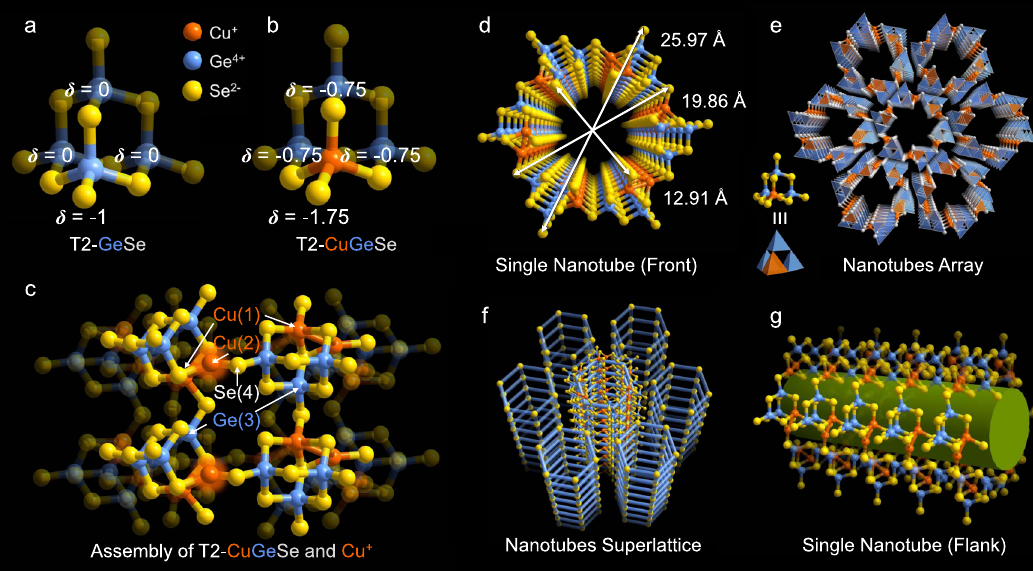
Fig. 2 Structure of 1. a Traditional homometallic supertetrahedral T2-GeSe cluster. b Heterometallic supertetrahedral T2-CuGeSe cluster ( δ represents the theoretical residual charge of the Se atoms surrounding the corner Ge or Cu sites). c The connection mode of the T2-CuGeSe cluster in 1. d As-formed single 1D nanotube of 1 viewed along the c -axis. e Packing diagram of 1 viewed along the c- axis. f Pillared stacking of the connected wheel clusters in the axial direction. g Flank view of a single nanotube. Colors: orange, Cu; blue, Ge; yellow,